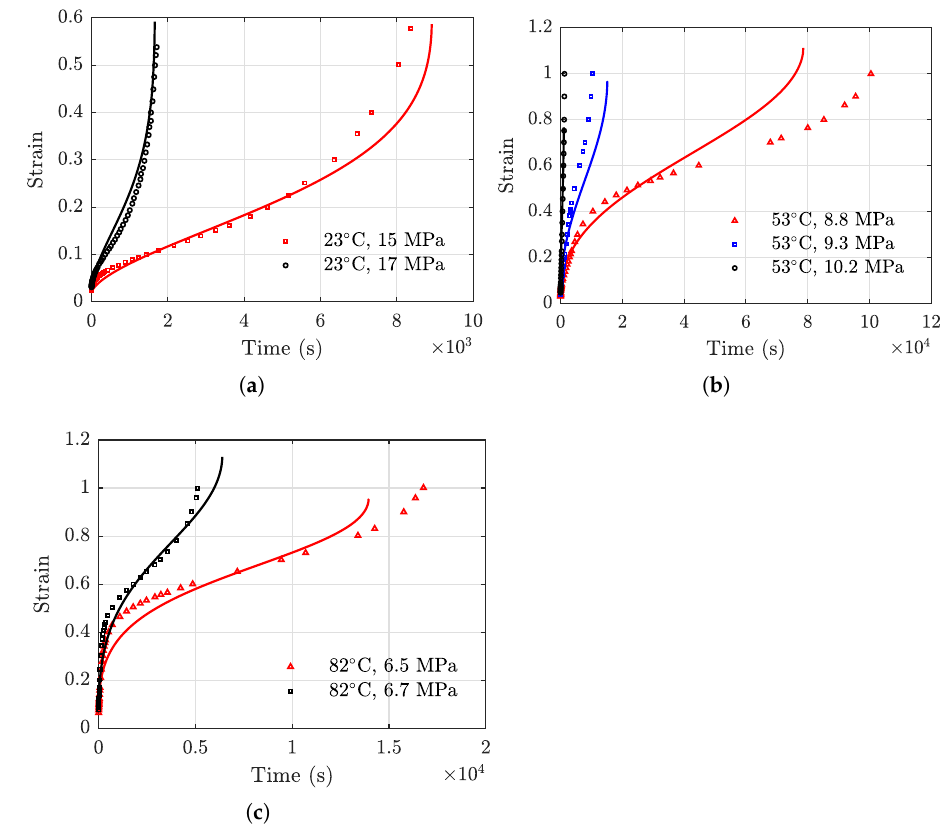
Figure 14. Comparisons of the model prediction results and the actual creep strain data reported in Ref. [55]. ( a ) 23 ◦ C, ( b ) 53 ◦ C, and ( c ) 82 ◦